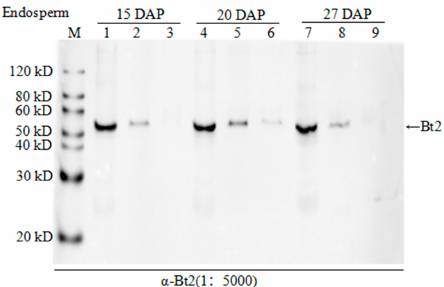
Figure 4. Enrichment of phosphorylated AGPase Bt2. 1, 4, and 7 were 20 μ g total protein extracted from maize endosperm 15, 20, and 27 days after pollination, respectively; 2, 5, and 8 were phosphorylated protein enriched from 200 μ g total protein by phos-tag TM agarose from maize endosperm 15, 20, and 27 days after pollination, respectively; 3, 6, and 9 were protein from